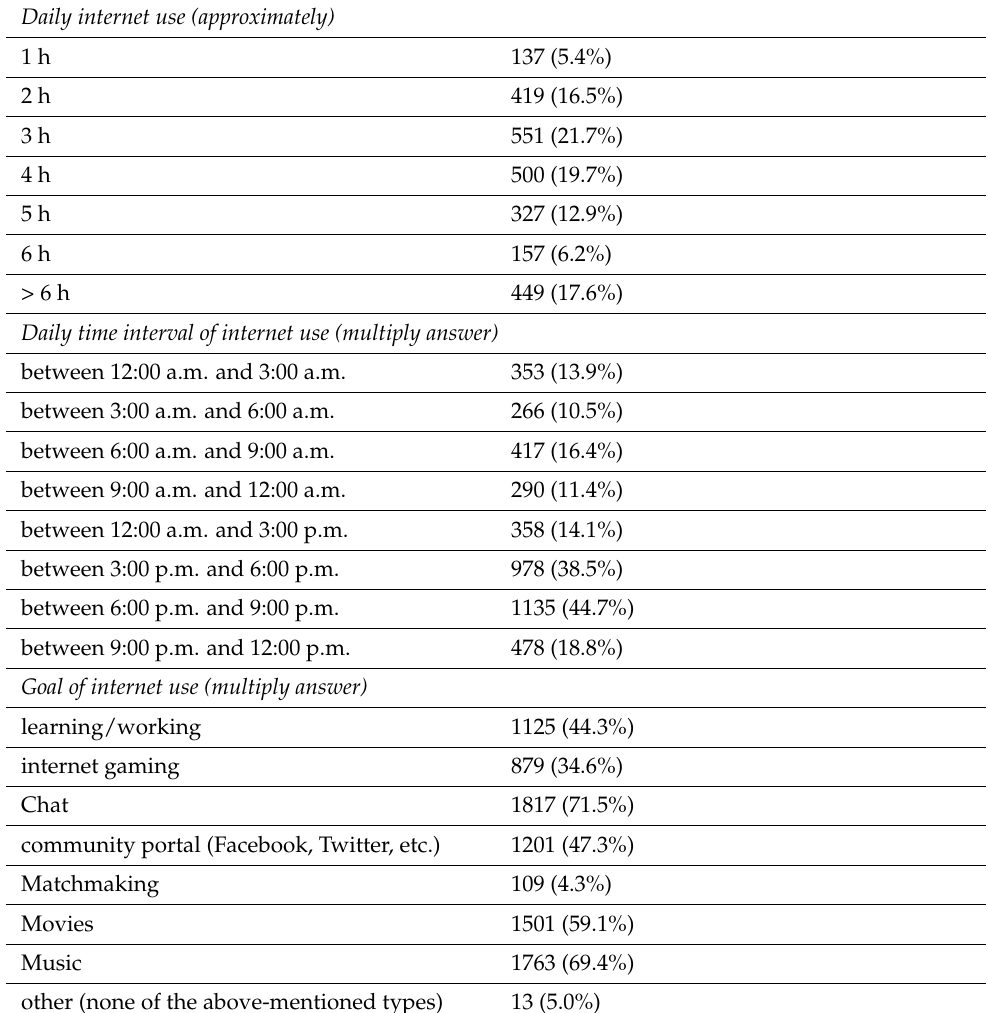
Table 3. Internet use in the study